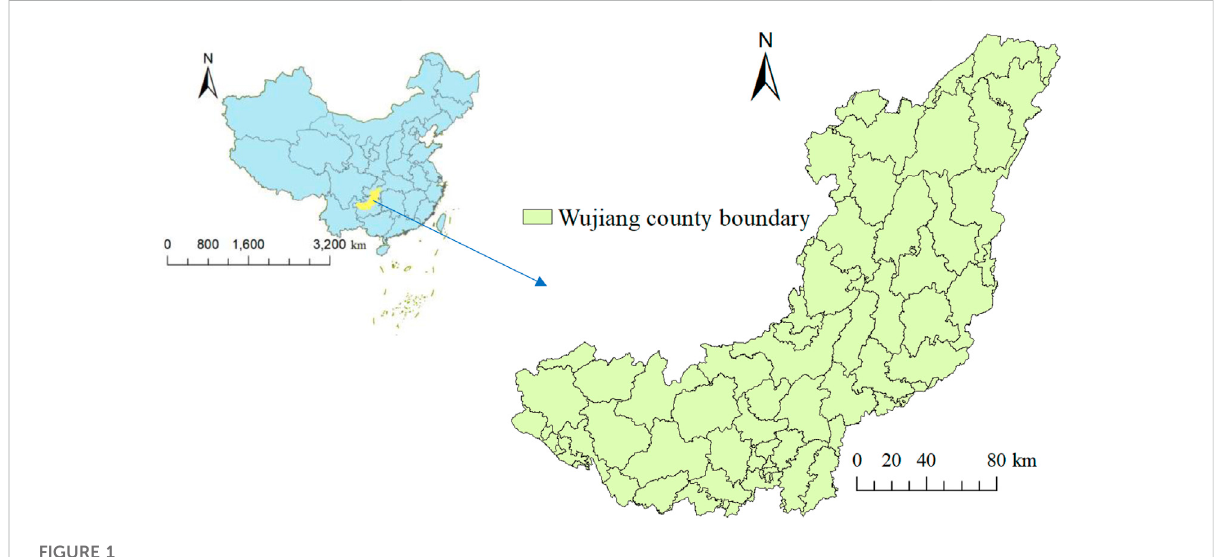
FIGURE 1 The position of Wujiang River Basin.